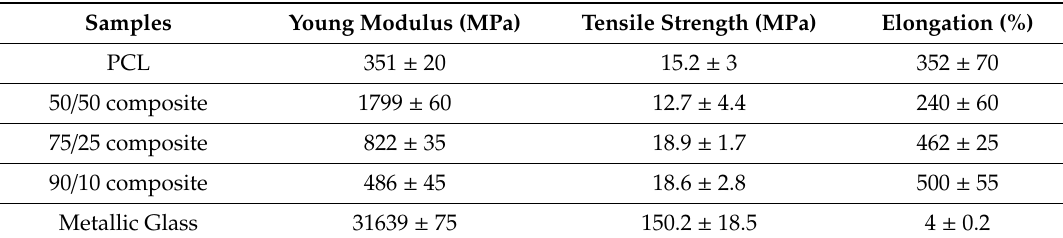
Figure 1. Tensile engineering stress-strain curves for ( a ) Mg 66 Zn 30 Ca 4 glassy ribbon, ( b ) pure polycaprolactone, and ( c ) Mg 66 Zn 30 Ca 4 /PCL 75/25 composite.